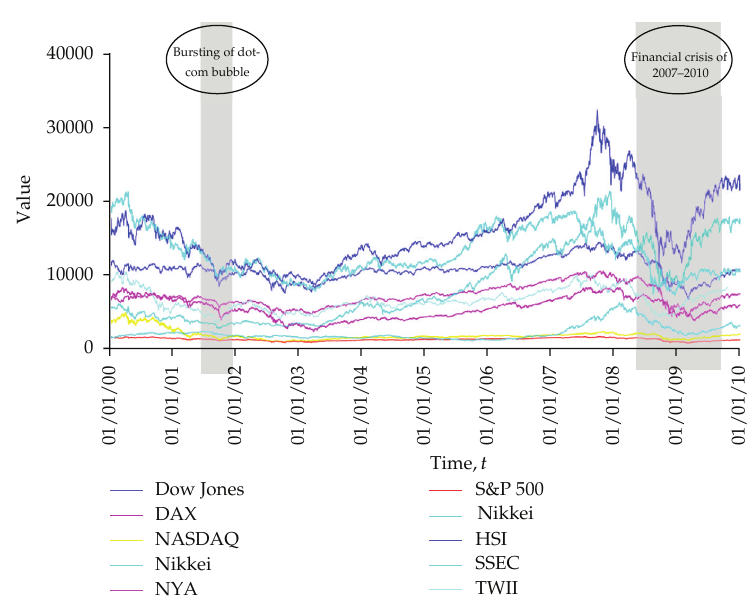
Figure 1: The temporal evolution of the daily closing value for the DAX, DJI, NASDAQ, Nikkei, NYA, BSE, SSEC, TWII, HIS, and S&P 500 indices and the main crisis, from Jan, 2000 to Dec, 2009.